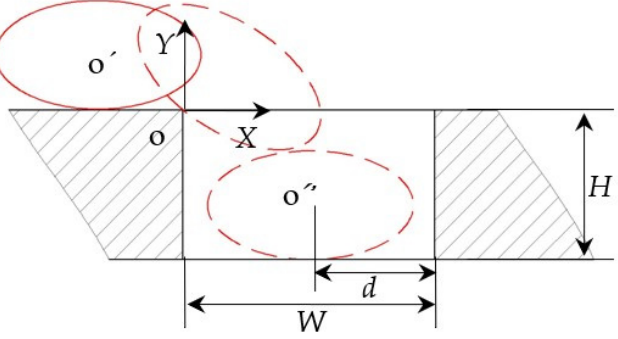
Figure 10. Schematic diagram of the seed falling into the shaped hole.